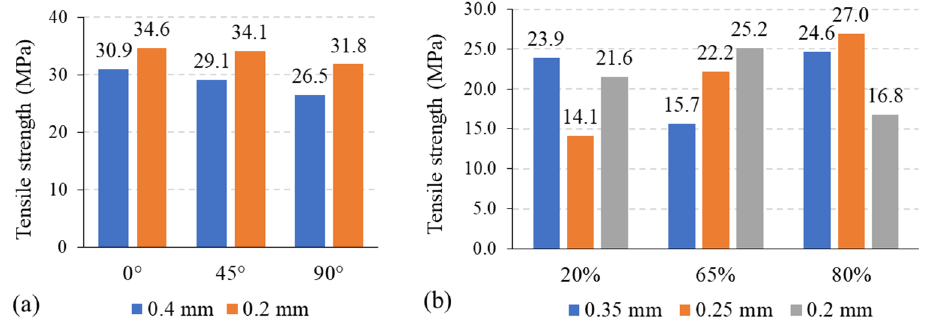
Figure 7. ( a ) ABS tensile strength sensitivity to layer thickness with different raster angles (in degrees)